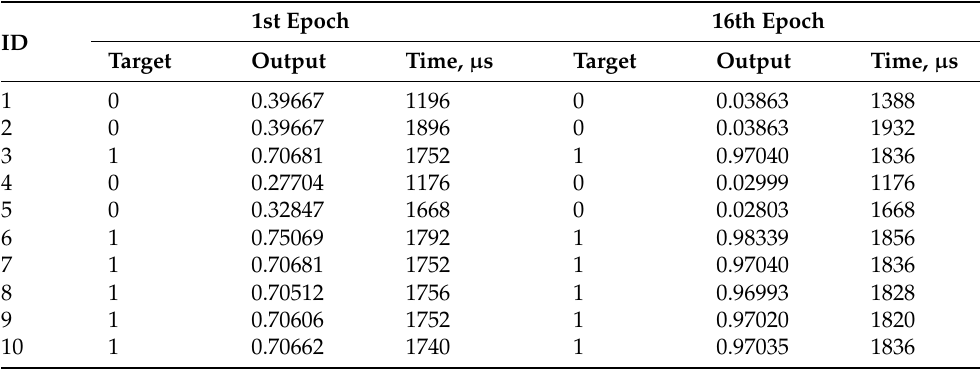
Table 4. Example of predicted ANN output (“Output”), normal/attack class (“Target”) and used time (“Time”) for the classification of first 10 network